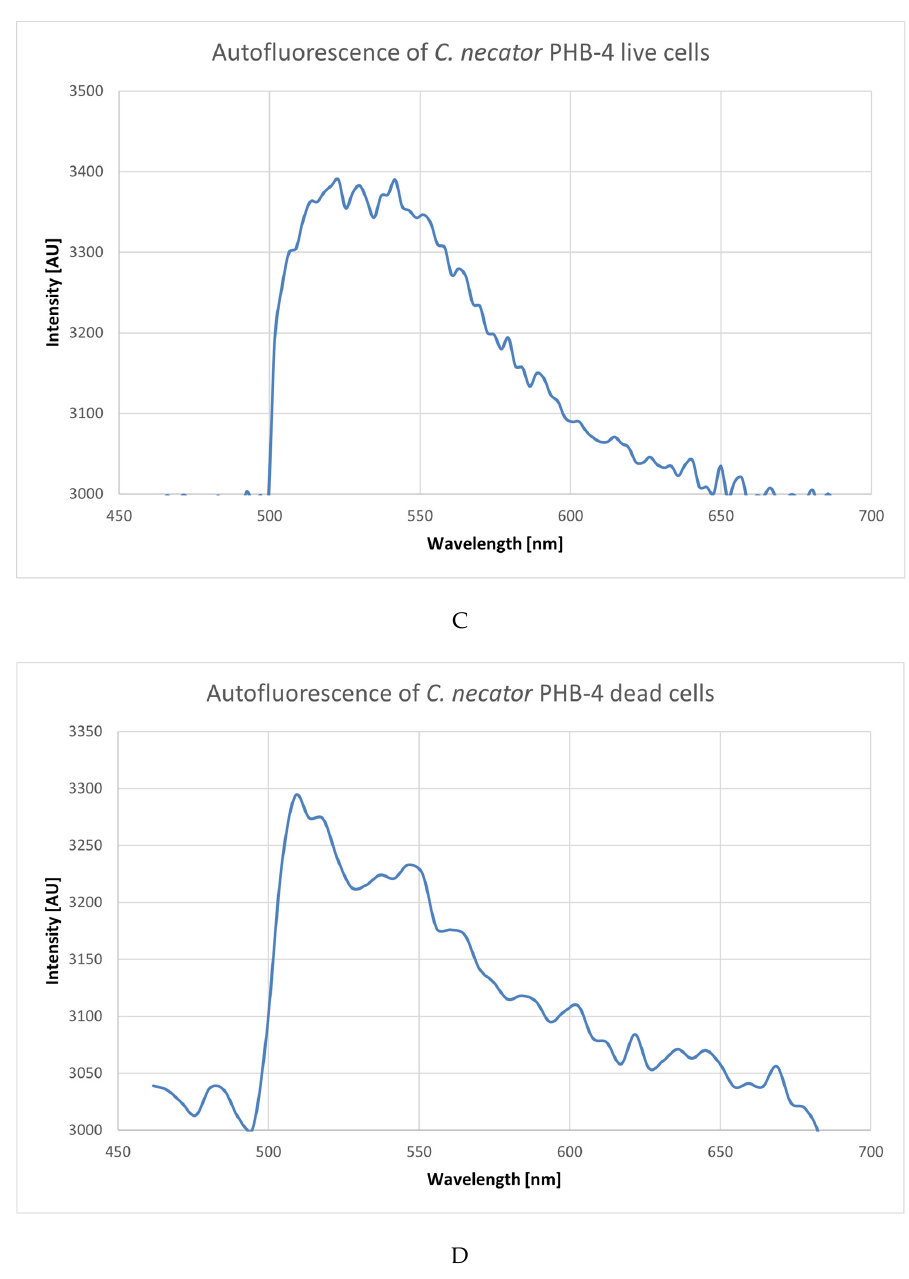
Figure 4. UV excitation with 266 nm laser. Emission spectra of the cultures of Cupriavidus necator H16 ( A , B ) and Cupriavidus necator PHB-4 ( C , D ), viable ( A , C ) and non-viable ( B , D ) cells. The cell concentration was 10 6 in 1 mL PBS buffer, 7.4 pH. The intensity is the same in all four cases—55 µJ. UV excitation can be used in certain cases and experiments when using UV excited stains such as LIVE/DEAD Fixable blue dead cell stain kit by Thermo Fischer or Hoechst 33342; however, we could not use it in our case as a lone method for defining bacterial viability. As a result, we explored the visible wavelengths lasers area possibilities only. As can be seen in Figure 5, the fluorescence of live cells is remarkably brighter (up to ten times the photon count). The answer to the question of why the dead cells still emit